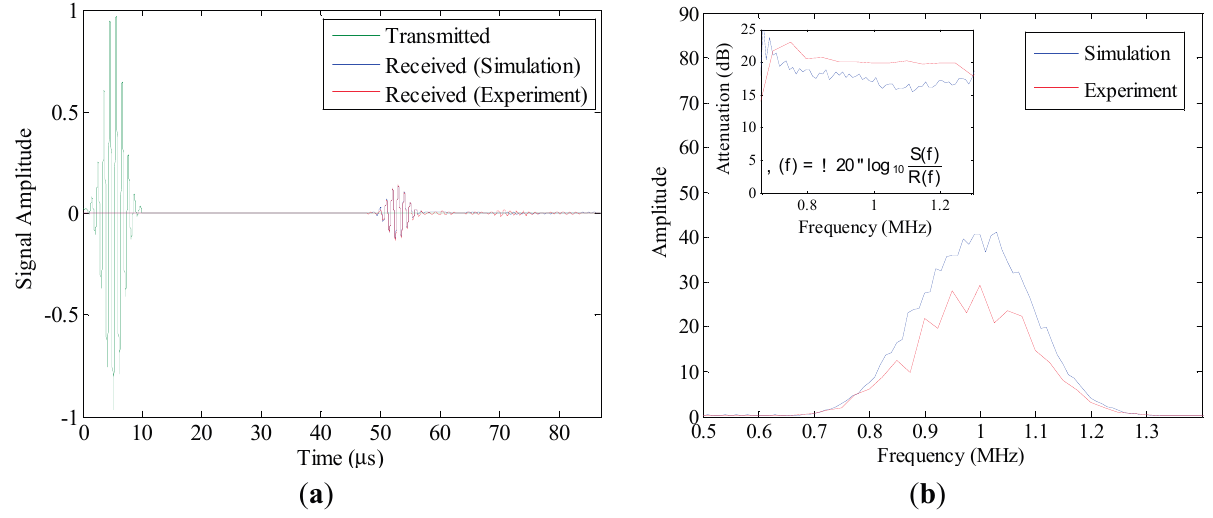
Figure 5. ( a ) Time function of the US transducer acting as transmitter, mean of 20 measurements and output of the reference simulation; ( b ) Amplitude spectra of the simulated signal and the mean signal recorded in experiment. In small window, attenuations [dB] in the simulated model and in the experiment are shown. Attenuations were calculated based on the provided formula, where α (f) is the attenuation [dB], log10 is the logarithm to the base 10, R(f) and S(f) respectively are the amplitude spectrum of the reference waveform ( i.e. , input signal) and the amplitude spectrum of a receiver waveform ( i.e. , received signal in experiment or in the reference